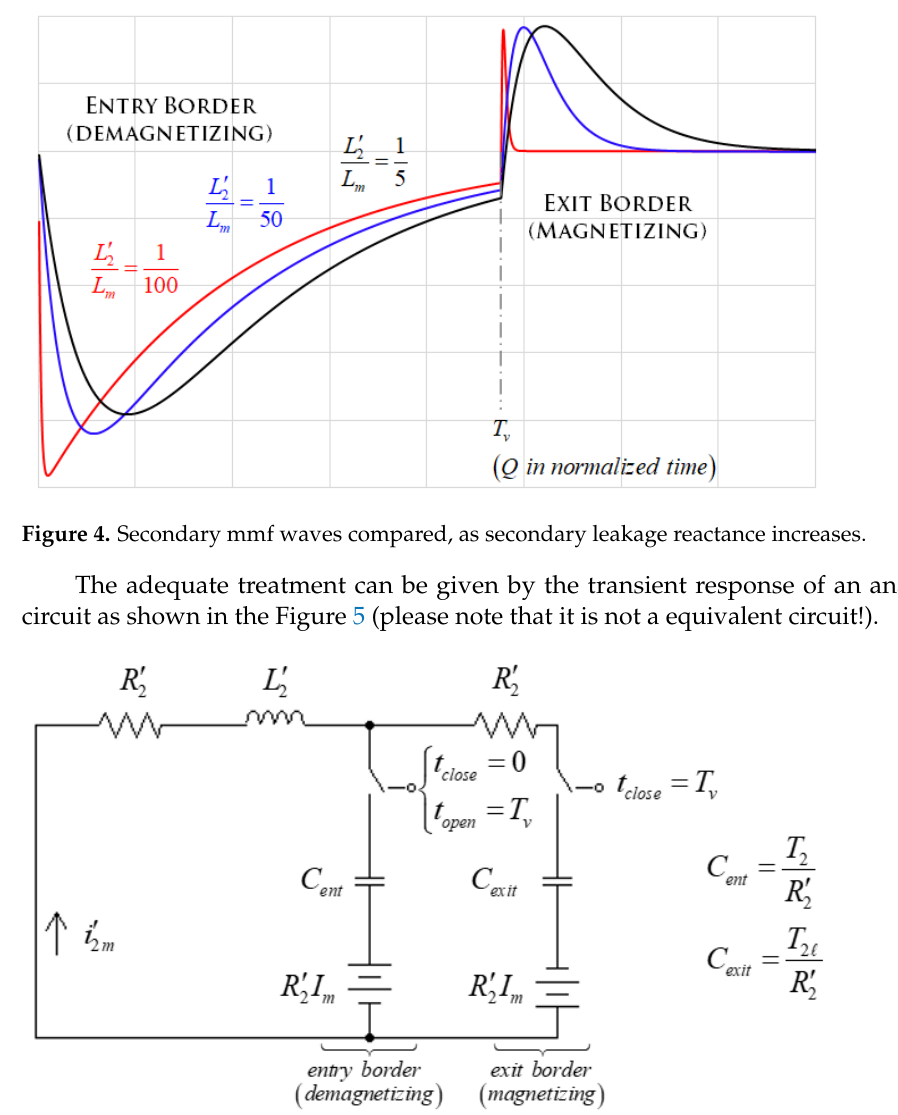
Figure 5. Analogous circuit to describe secondary mmf reaction